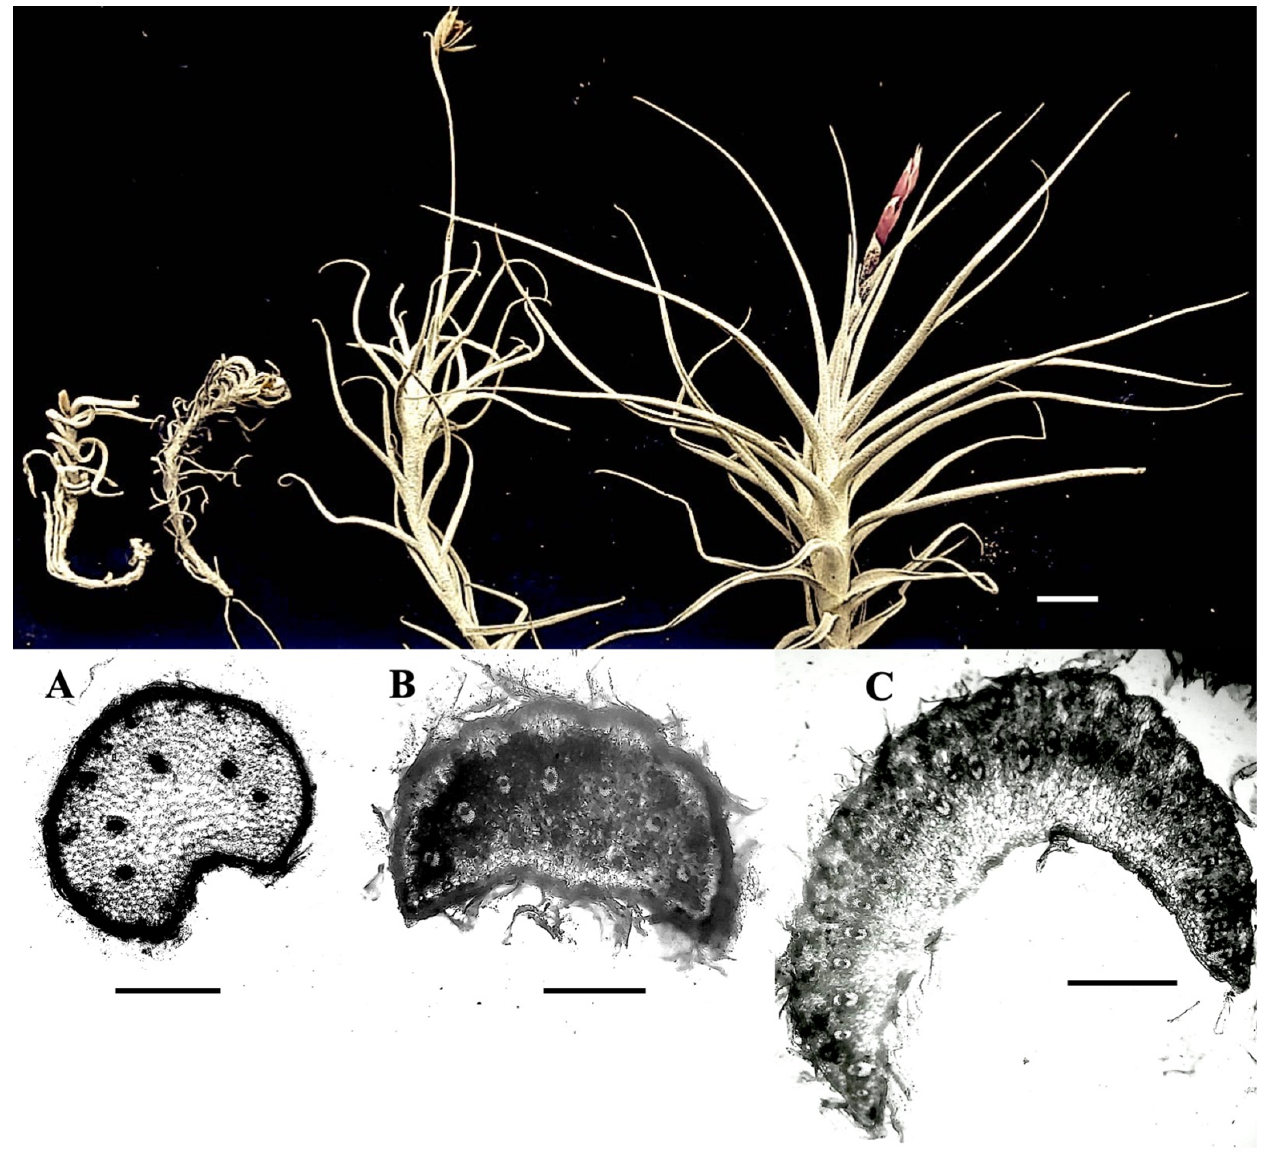
Figure 2. Tillandsia leaf, up: natural expansion, down: cross-section. ( A ). Tillandsia virescens . ( B ): Tillandsia landbeckii , ( C ): Tillandsia marconae . Black bars: 1 mm. White bar: 10 mm.